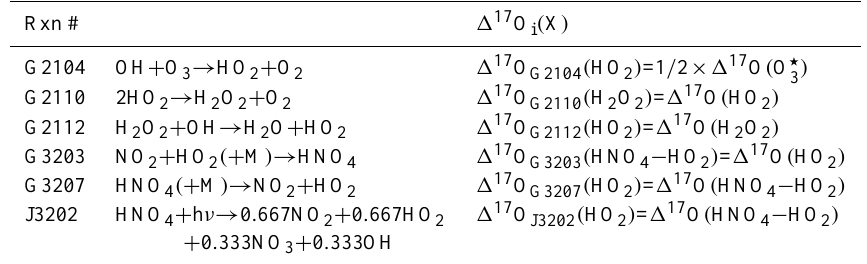
Table 3. 1 17 O i ( X ) for Case 3: explicit NO x and HO x . Only equations featuring 1 17 O i ( HO 2 ) different from 0‰ are presented here.